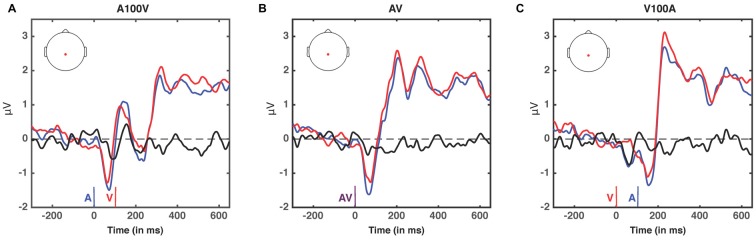
ERPs at non-significant SOAs; A100V (A), AV (B) and V100A (C). ERPs are presented for electrode 55, a centro-parietal electrode participating in each of the significant clusters (audio-leading vs. visual-leading at t−1, see Figure 6). ERPs when the preceding trial was audio-leading are depicted in blue, and ERPs when the preceding trial was visual-leading are depicted in red. The difference wave (audio-leading − visual-leading) is illustrated in black. Onset of auditory stimulus (blue), visual stimulus (red), and synchronous audiovisual stimulus (purple) are illustrated by vertical bars. No significant differences were found (all p > 0.17, randomization test).